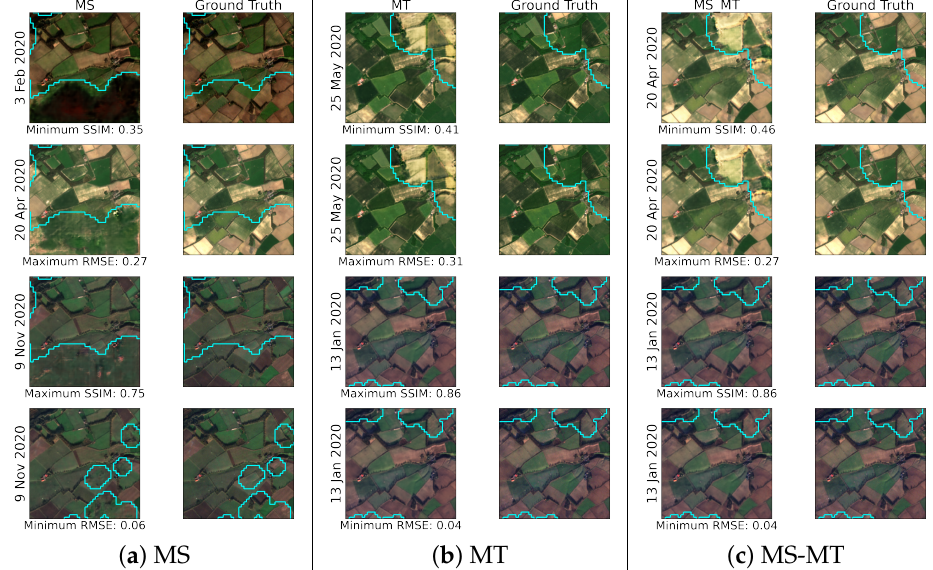
Figure 9. Reconstructions with the lowest ( top two rows ) and highest ( bottom two rows ) perfor- mance for both SSIM and RMSE for the Scotland region. Each row contains all three stacked modes (MS, MT, and